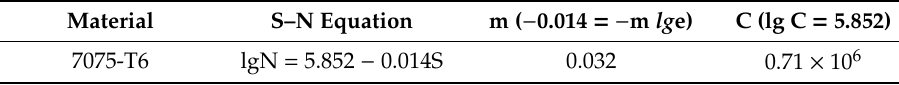
Figure 5. Corrosion fatigue S–N curve of the FSW specimens. Table 5. S–N curve equations and